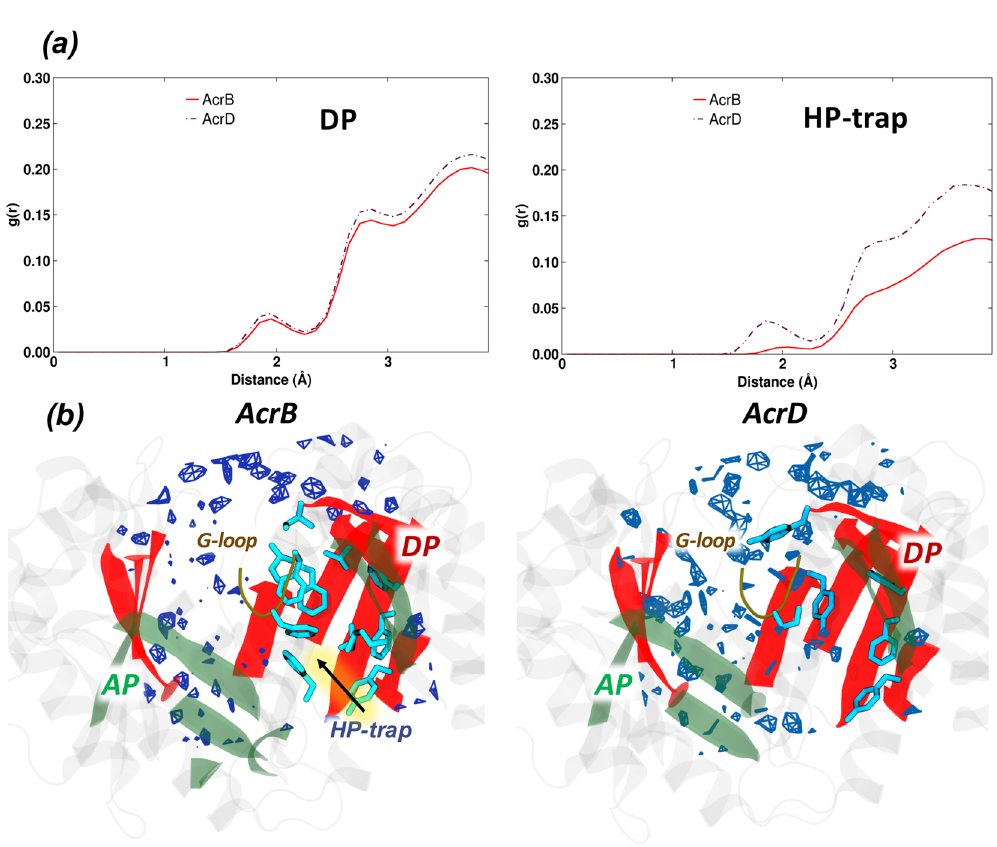
Figure 8. Hydration of DP and HP-trap in the Tight protomer of AcrB and AcrD. ( a ) Comparison of RDF profiles of water oxygen atoms around the DP (all atoms) and HP-trap (all atoms) in the Tight protomer of AcrB (red solid line) and the corresponding regions of AcrD (brown dash-dotted line). ( b ) Comparison of SDF for waters in the DP calculated over the configurations forming the most populated cluster of AcrB (left) and AcrD (right) illustrating the variation in the immediate environment of the hydrophobic residues. The position of the HP-trap in DP of AcrB is indicated by an arrow. See Fig. 5 for further